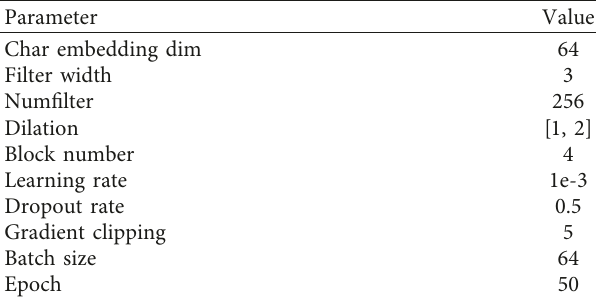
Table 5: Hyperparameter